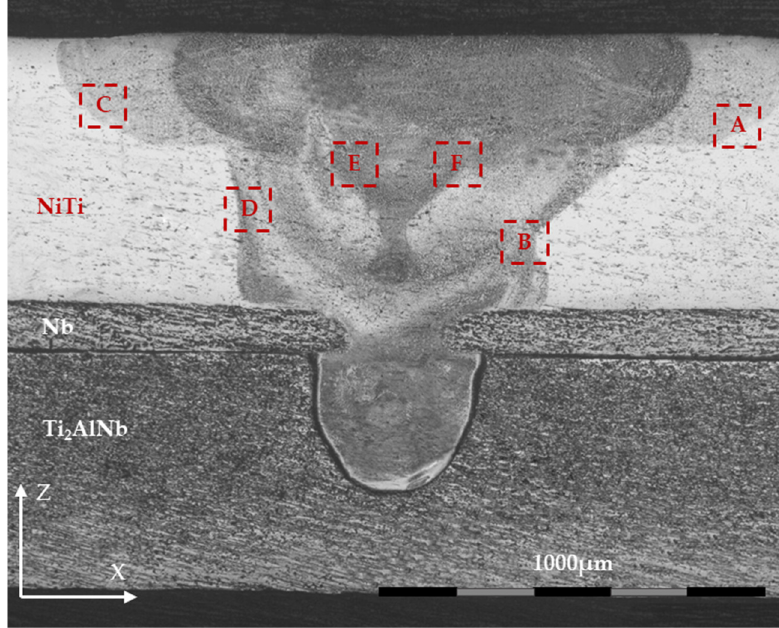
Figure 3. Macro morphology of weld cross section (No. 3